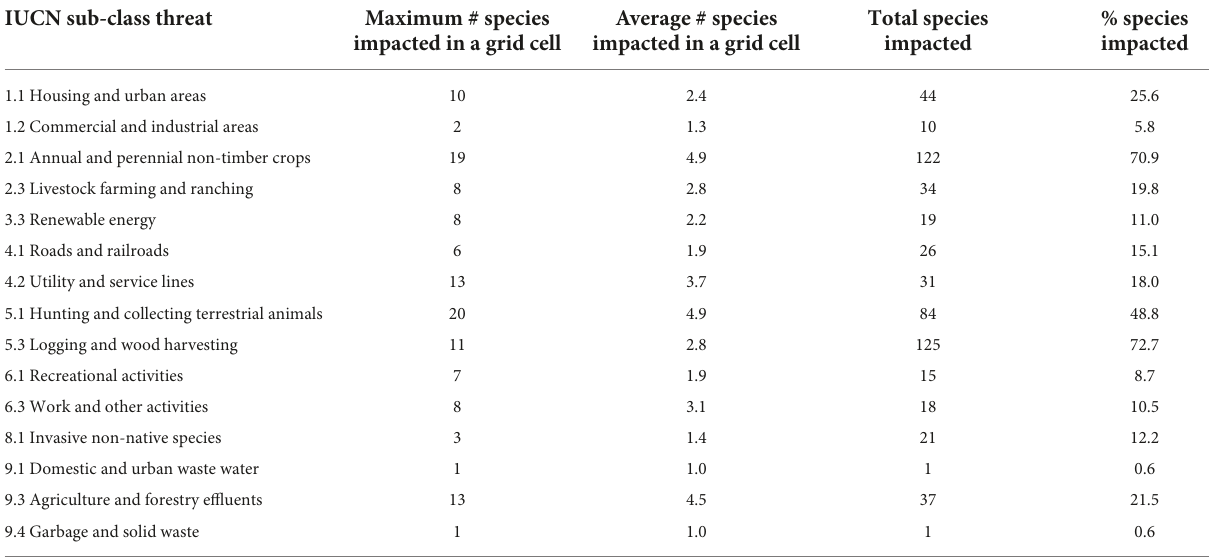
TABLE 4 Threats listed by the International Union for Nature Conservation (IUCN) and the maximum and average number of species they impact per grid cell, and the total number and percentage of species they impact. IUCN sub-class